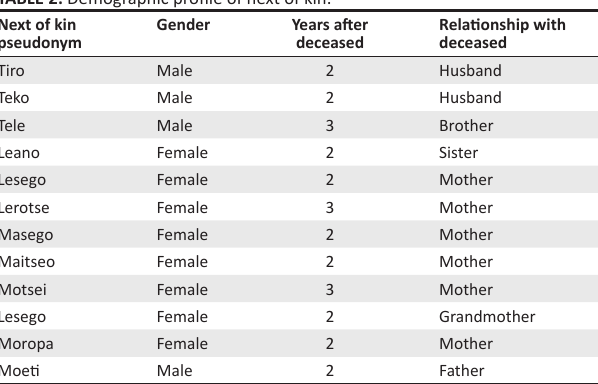
TABLE 2: Demographic profile of next of kin.